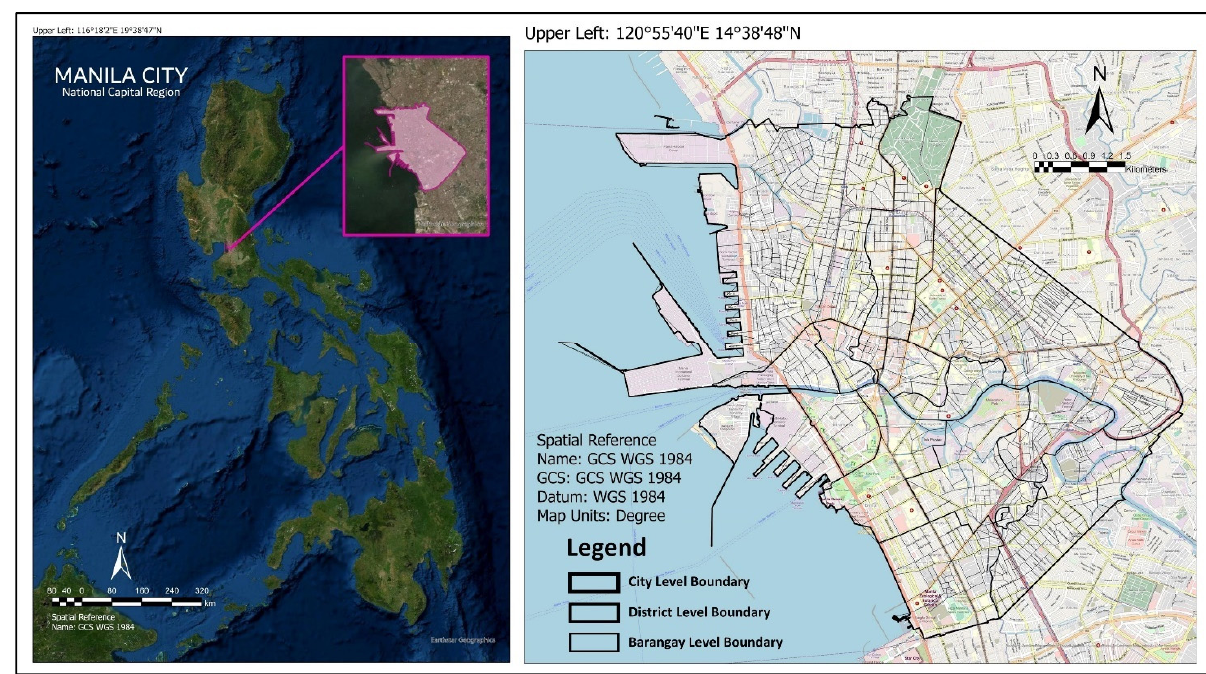
Figure 1. Manila City’s geographical location ( left ) and administrative boundary ( right ).